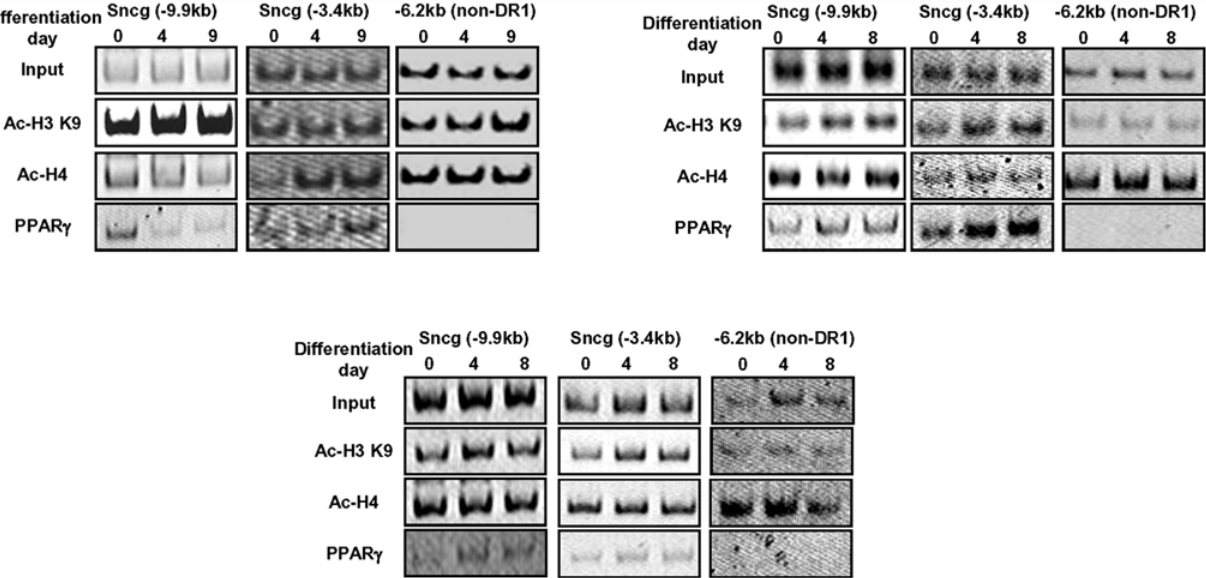
Fig 2. Temporal changes in PPAR γ binding at predicted DR1 sites in the promoter region of the murine Sncg gene during 3T3-L1 adipocyte differentiation. ChIP studies were performed in pre-adipocytes and maturing adipocytes at days 4 and 8 post-differentiation initiation, employing anti-PPAR γ antibody and sequence-specific primers for putative DR1 sites (PPAR-response elements) located at promoter regions — 9.9 and — 3.4kb, and a non-DR1 site at-6.2 kb, relative to the murine Sncg start codon. Also shown are histone acetylation patterns at each site, employing anti-acetylated histone-3 K9 (Ac- H3 K9) and anti-acetylated histone-4 pan (Ac-H4). Images are results from 3 independent experiments. Amplicon sizes are described in the text, and a representative image showing DNA band sizes is provided as S1